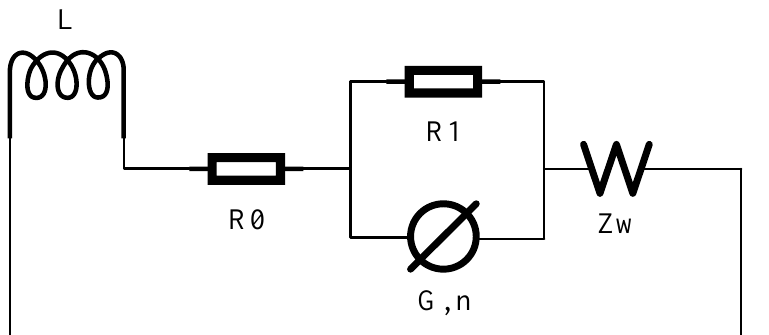
Figure 3. The equivalent circuit of the whole battery.